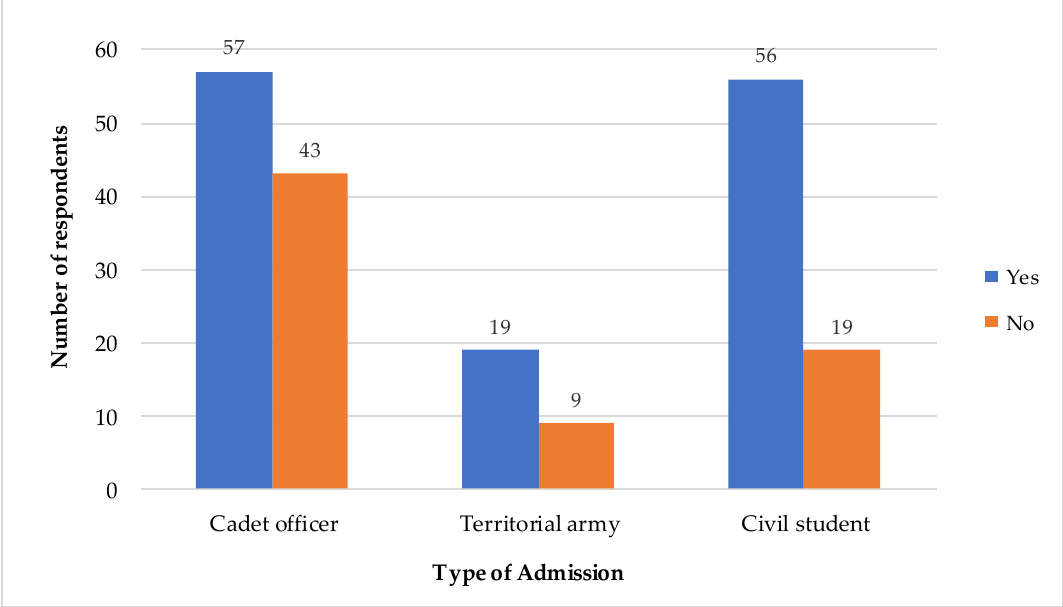
Figure 2. Distribution of use of antibiotic in the previous year within different years of study ( n = 204).